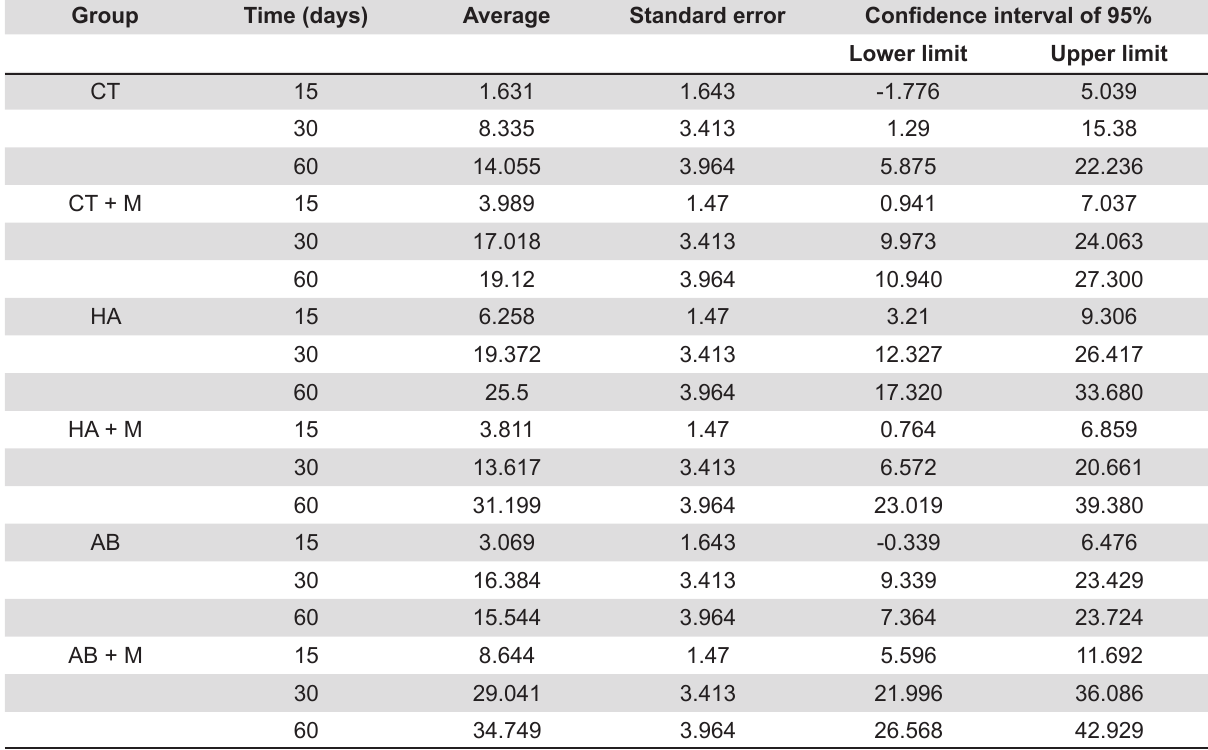
Table 1- Bone fill percentages in all experimental groups after 15, 30, and 60 postoperative